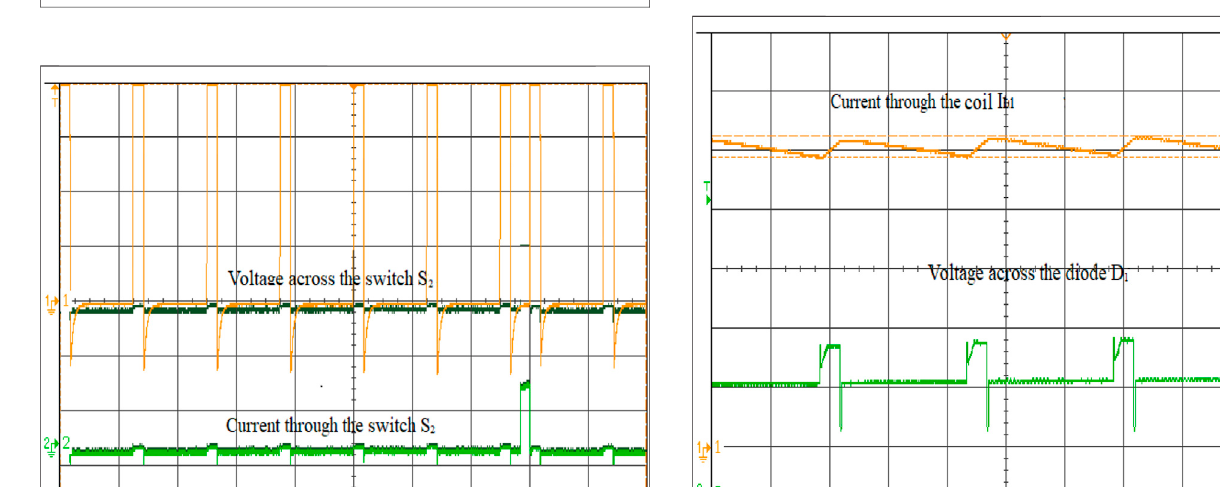
FIGURE 9 | Characteristics of switch S 1 .